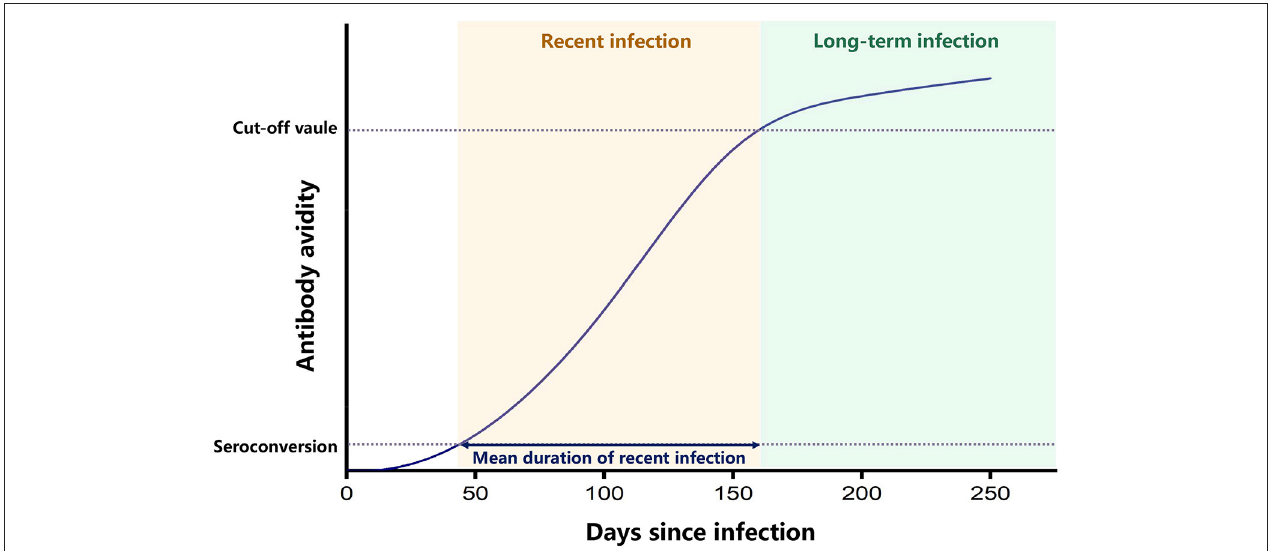
FIGURE 1 | Principle of LAg-EIA. This graph indicates that after seroconvertion, the avidity of HIV-specific antibody increases along time and reaches a plateau after the mean duration time of recent infection. Enzyme immunoassay was performed to test the avidity of HIV-specific antibody, and the ODn value of test results can represent the avidity level. The recent infection is classified when ODn value is lower than the cut-off value, and the long-term infection is classified when ODn value is higher than the cut-off